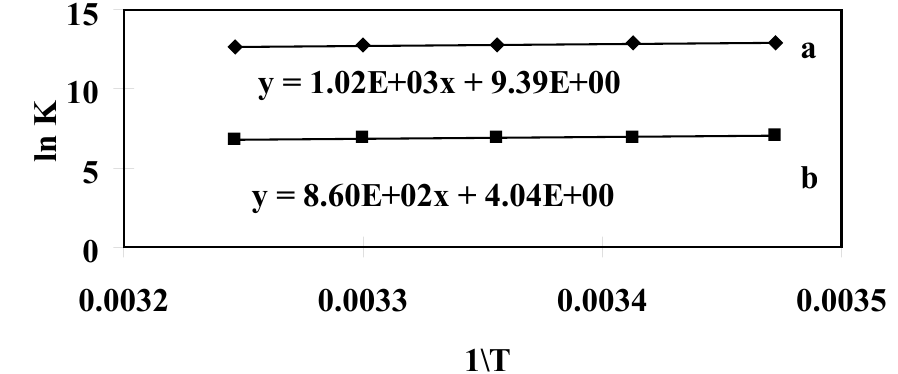
Figure 2. Effect of temperature on acid-base equilibria of cbdca, where a and b correspond to Reactions 4 and 5 in Table 5, respectively.